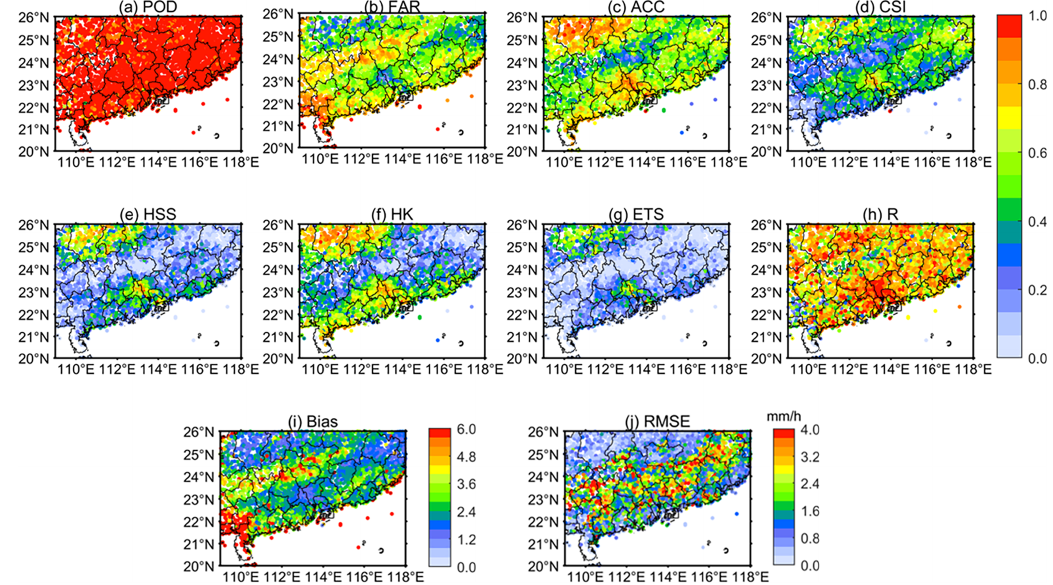
Figure 11. Spatial distribution of evaluation indicators of the QPE algorithm for all stations: (a) POD; (b) FAR; (c) ACC; (d) CSI; (e) HSS; (f) HK; (g) ETS; (h) R ; (i) Bias; (j) RMSE.